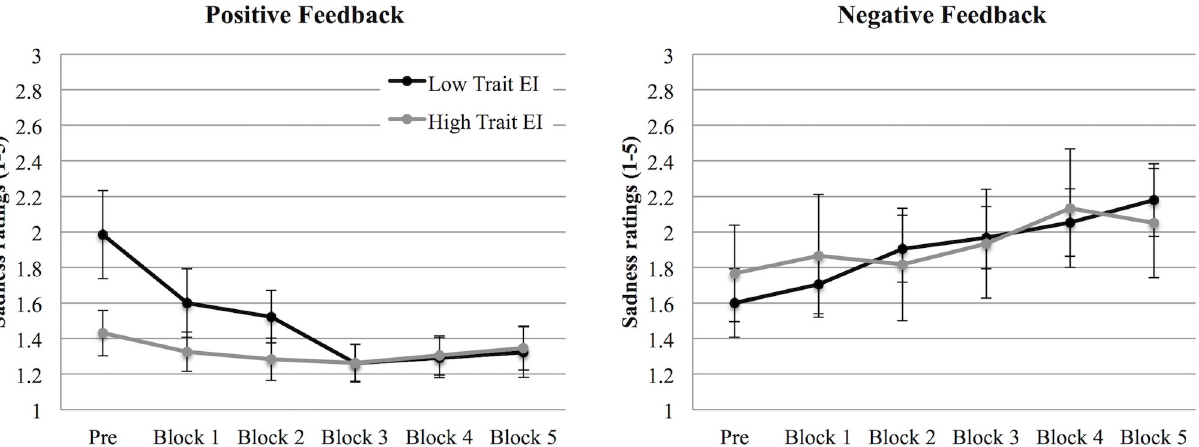
Fig 3. Sadness (Study 1). Sadness intensity at the beginning of the experiment (PRE) and after each block in the negative (left panel) and in the positive (right panel) feedback conditions for low and high trait EI participants. Error bars indicate 1 standard error above or below the mean.